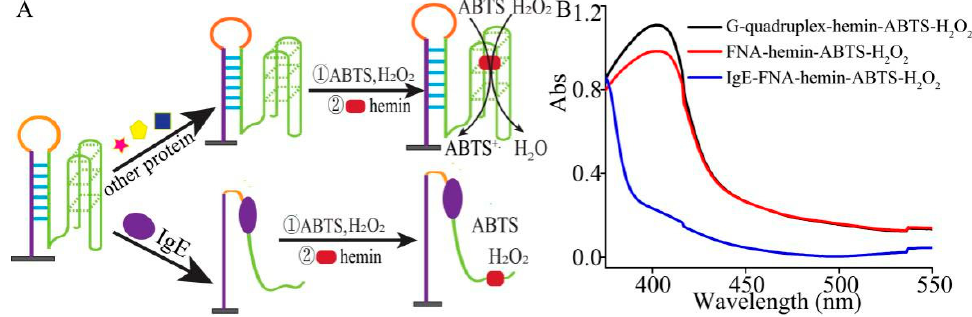
Figure 1. ( A ) Schematic illustration of IgE assay based on functional nucleic acid (FNA); ( B ) UV − vis spectra in the DNAzyme/FNA-mediated ABTS-H 2 O 2 system.